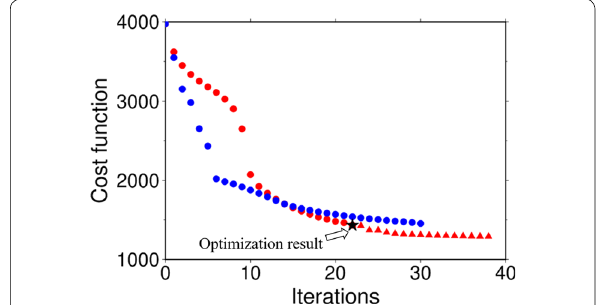
Fig. 8 Cost functions in the case of applying real GNSS time series. The red circles indicate the change in the cost function values only when the frictional parameters are optimized. The black star indicates the optimization result. The red triangles indicate the further updates of the frictional parameters when L 49 , a highly sensitive parameter of the cost function, is fixed to the optimum value. The blue circles show the results when simulation variables and frictional parameters are simultaneously